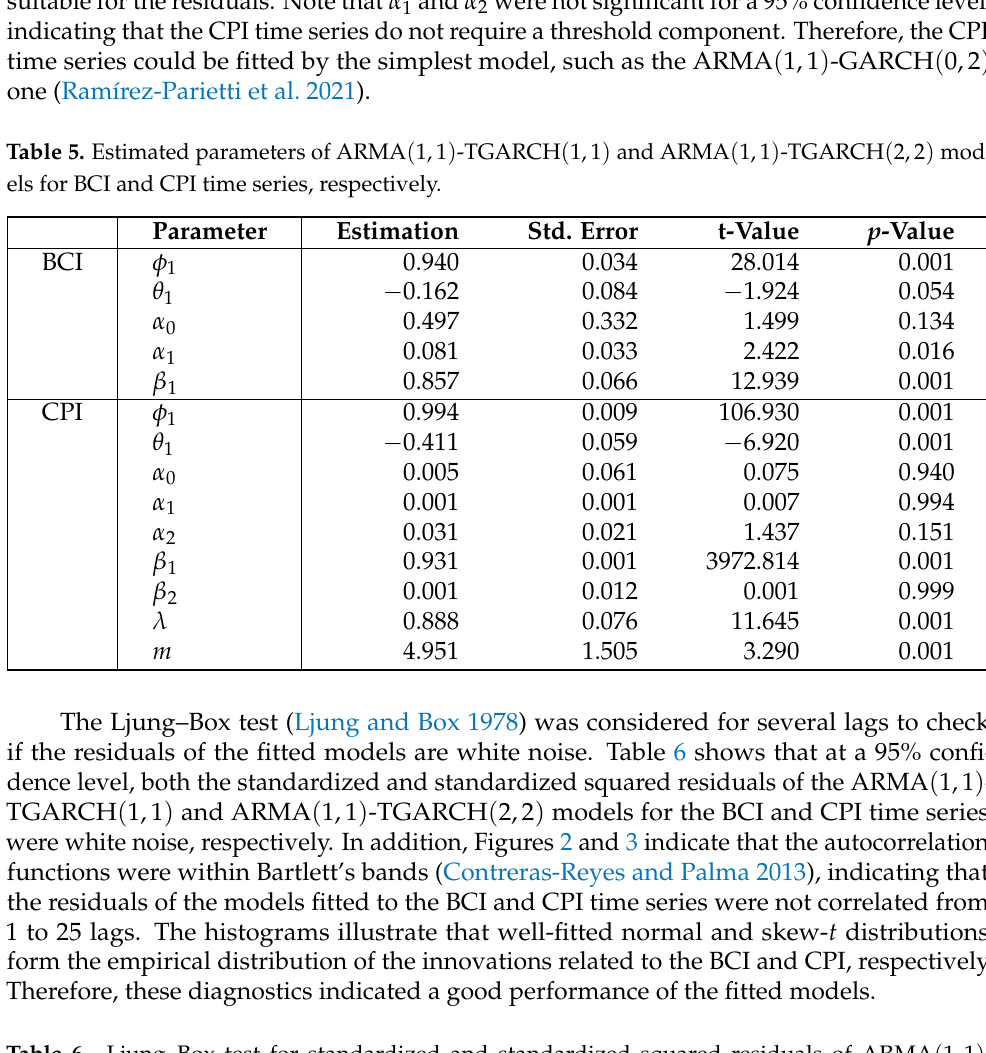
Table 6. Ljung–Box test for standardized and standardized squared residuals of ARMA ( 1,1 ) - TGARCH ( 1,1 ) and ARMA ( 1,1 ) -TGARCH ( 2,2 ) models for BCI and CPI time